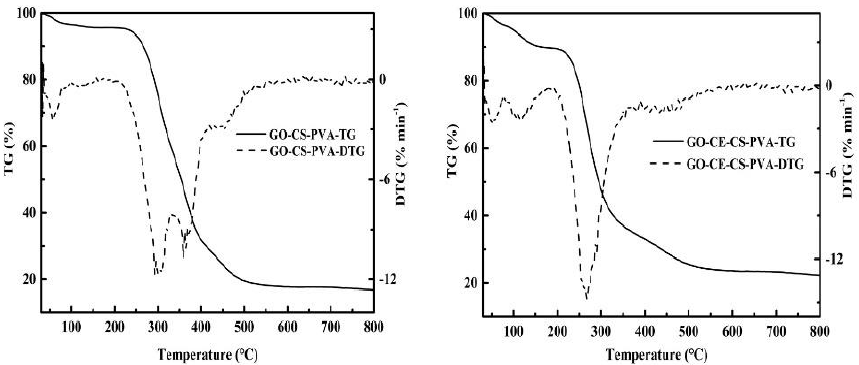
Figure 5. Thermogravimetric analysis diagram of GO − CE − CS − PVA and GO − CS − PVA.